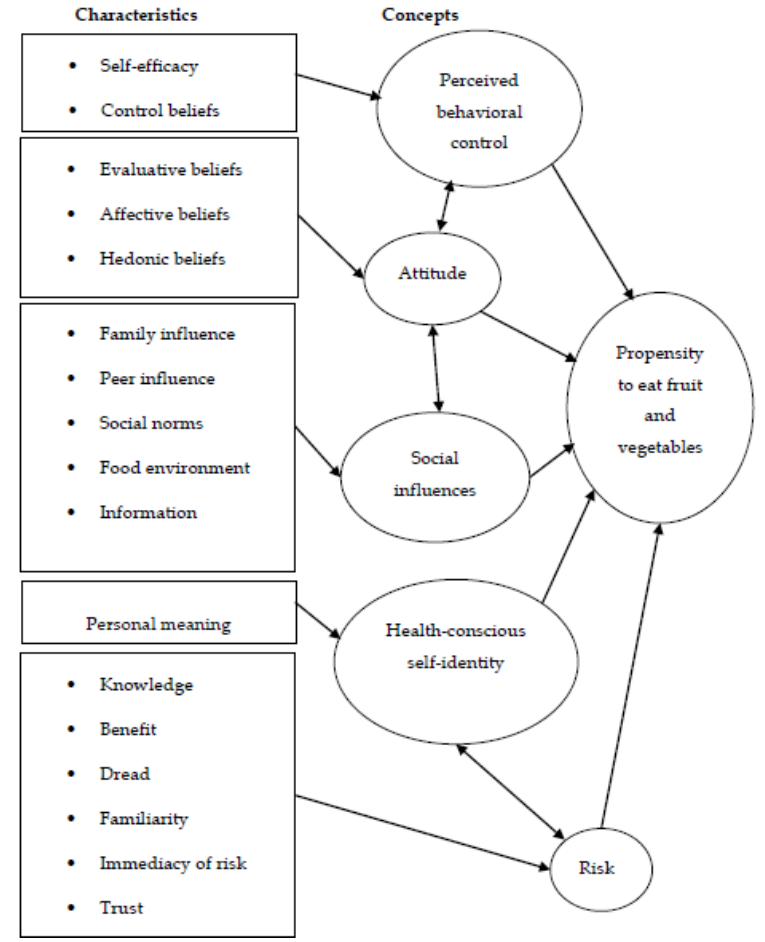
Figure 1. Proposed conceptual framework for the exploration of fruit and vegetable consumption in young men.